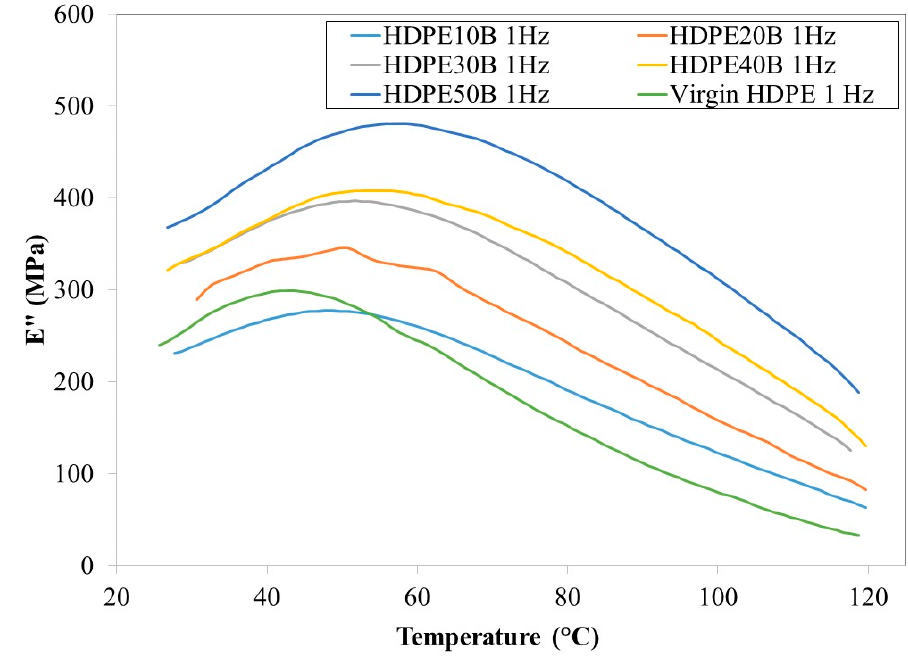
Figure 8. Loss modulus of HDPE/birch fiber composites at 1 Hz.